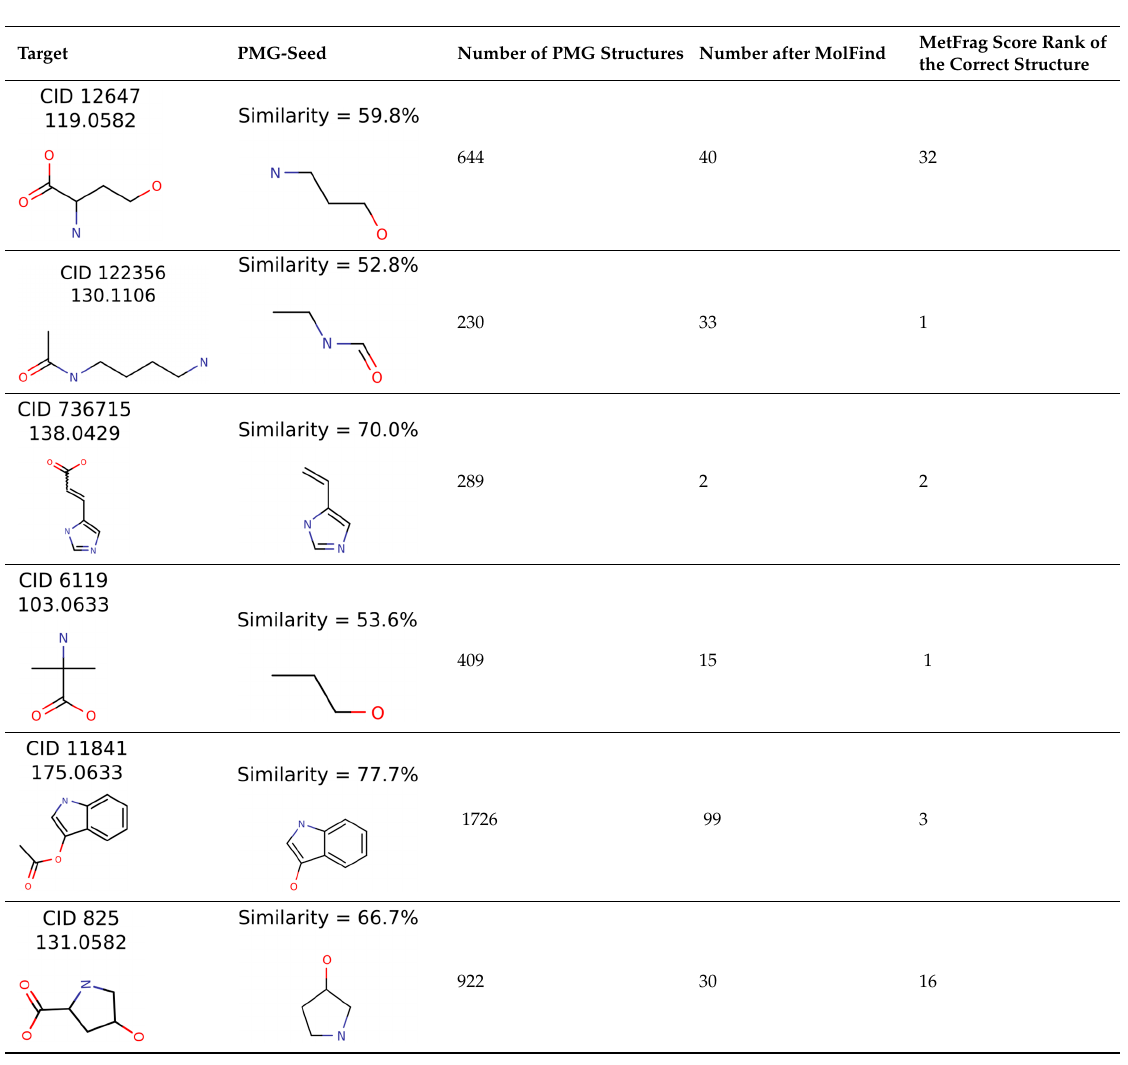
Algorithm-3–6 generated the second highest (21) number of correct PMG-Seed structures. Of Algorithm-3-6 generated the second highest (21) number of correct PMG-Seed structures. Of the Algorithm-3-6 generated the second highest (21) number of correct PMG-Seed structures. Of the Algorithm-3-6 generated the second highest (21) number of correct PMG-Seed structures. Of the Algorithm-3-6 generated the second highest (21) number of correct PMG-Seed structures. Of the